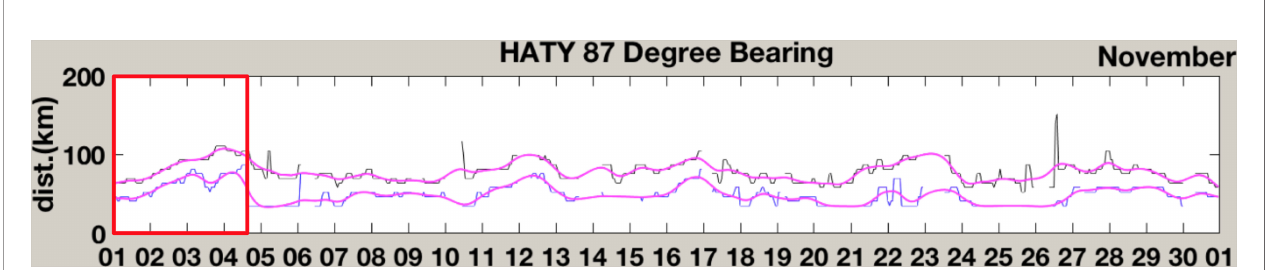
FIGURE 12 | Estimates of the range from the HATY HFR on the 87 degree bearing to the GS edge (blue) and jet (black), with magenta 28.5 hour low-pass cubic spline smoothing of all estimates.